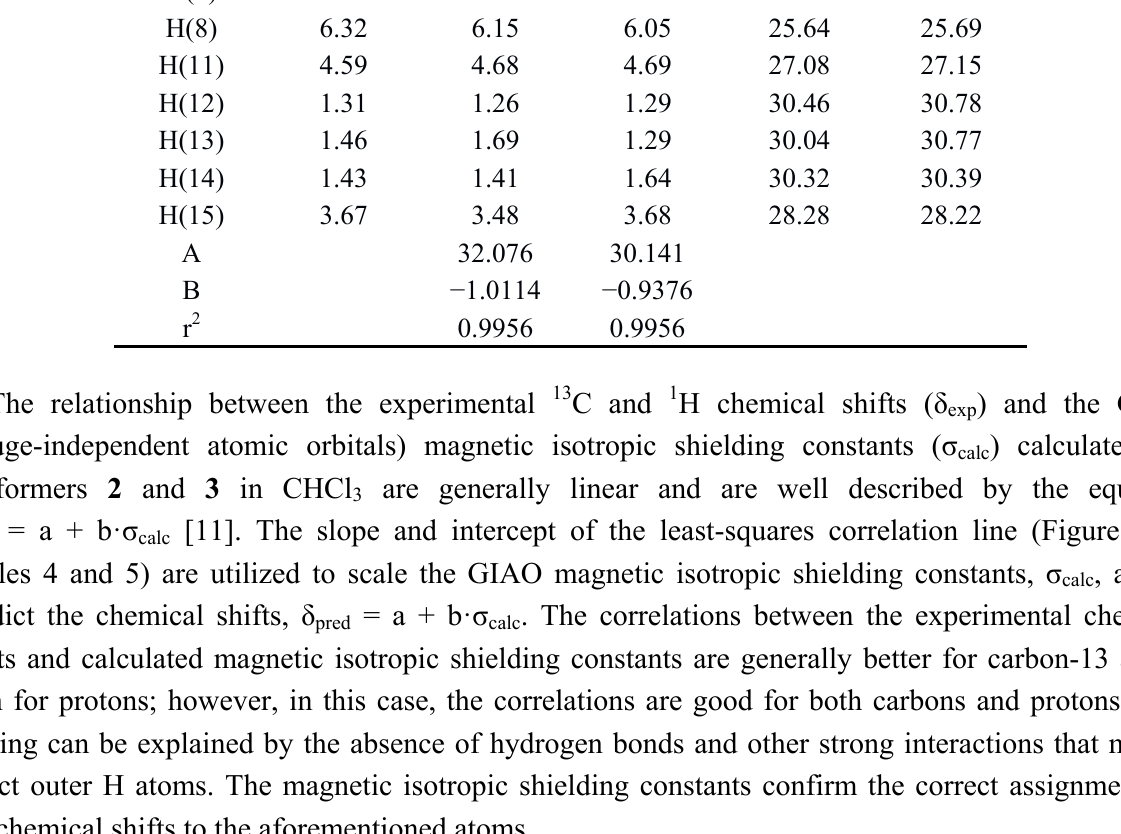
, CDCl ) vs. the isotropic magnetic shielding exp 3